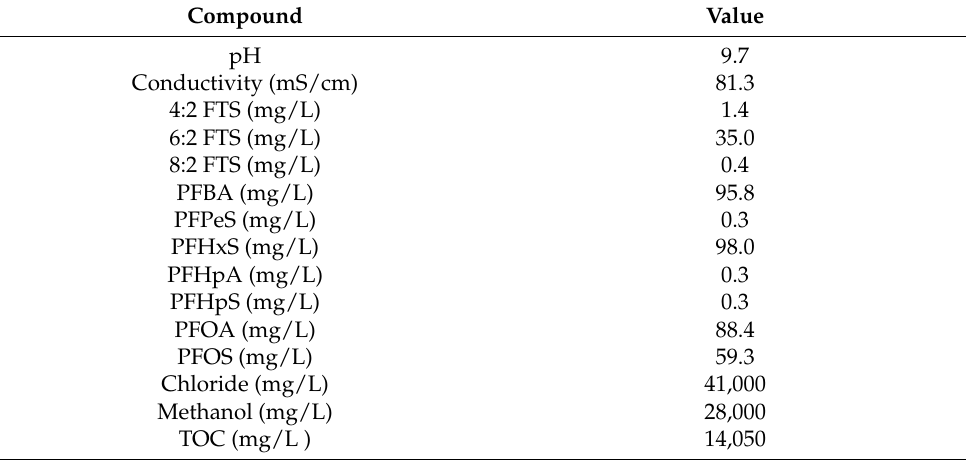
Table A2. Characterization of the real still bottoms solution used for the electrochemical treatment of PFAAs at the laboratory scale.